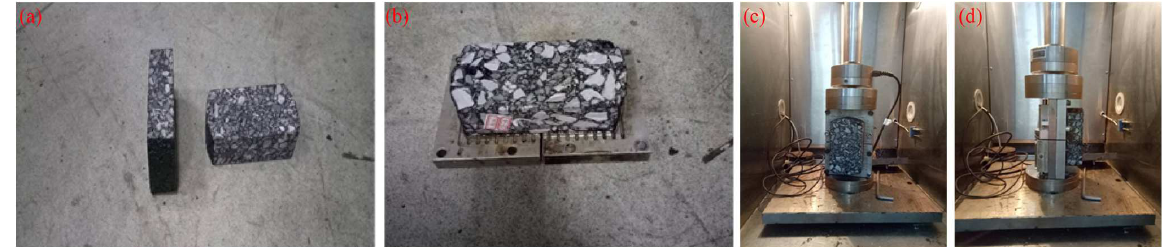
Figure 2. Fabrication of the OT specimen: ( a ) OT specimen; ( b ) paste OT specimen; ( c ) the front view OT; ( d ) the side view OT.